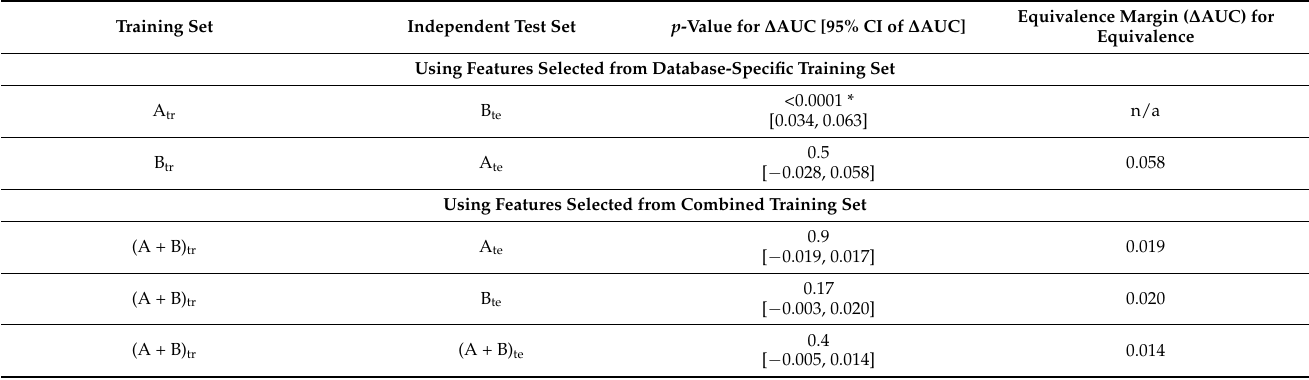
Table 3. Difference in area under the receiver operating characteristic curve ( ∆ AUC), p -value for comparison, and, when ∆ AUC fails to show statistically significant difference, equivalence margin for equivalence and non-inferiority, when using combinations of separate training and independent test sets. The difference in AUC ( ∆ AUC) is determined as AUC post-harmonization -AUC pre-harmonization . An asterisk (*) indicates statistically significant difference (including after adjusting the criteria using the Bonferroni correction for significance due to multiple comparisons, when